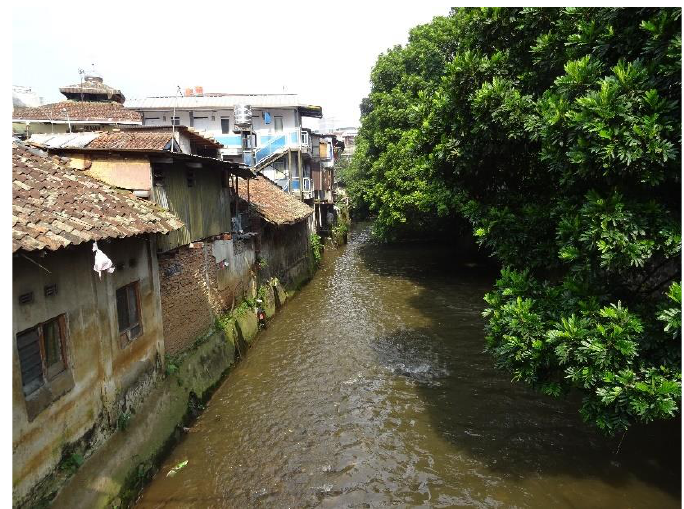
Figure 4. A kampung in Bandung, Indonesia. Photo by A. Samalavičius .